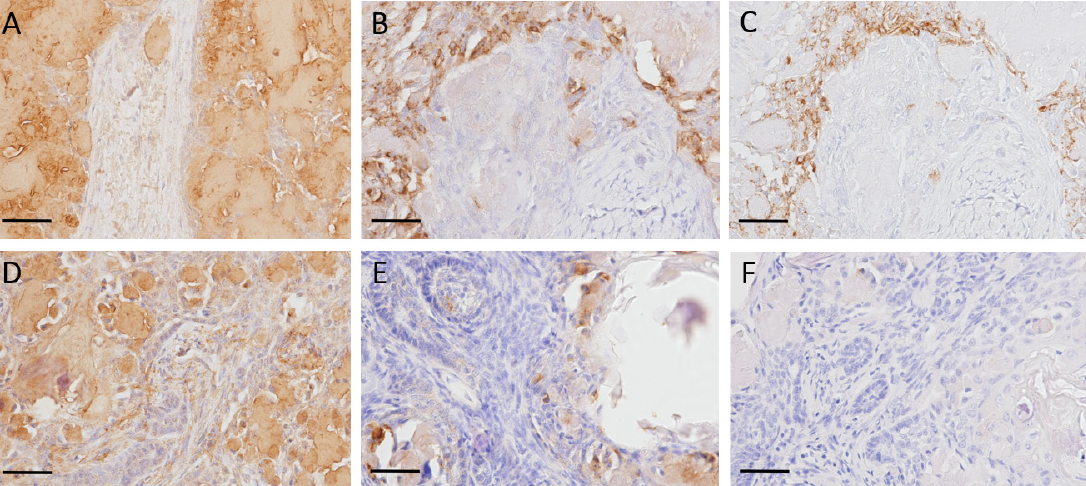
Figure 3. Immunohistochemistry of amyloid-producing ameloblastoma (APAB) in dogs and cats. ( A – C ) APAB; dog No. 3. Amyloid deposits were strongly positive to N-terminal region of ameloblastin ( A ), weakly positive to odontogenic ameloblast-associated protein ( B ), and negative to ameloblastin middle region ( C ). ( D – F ) APAB; cat No. 2. Amyloid deposits were strongly positive to N-terminal region of ameloblastin ( D ), weakly positive to odontogenic ameloblast-associated protein ( E ), and negative to ameloblastin middle region ( F ). Scale bars: 400 µm.